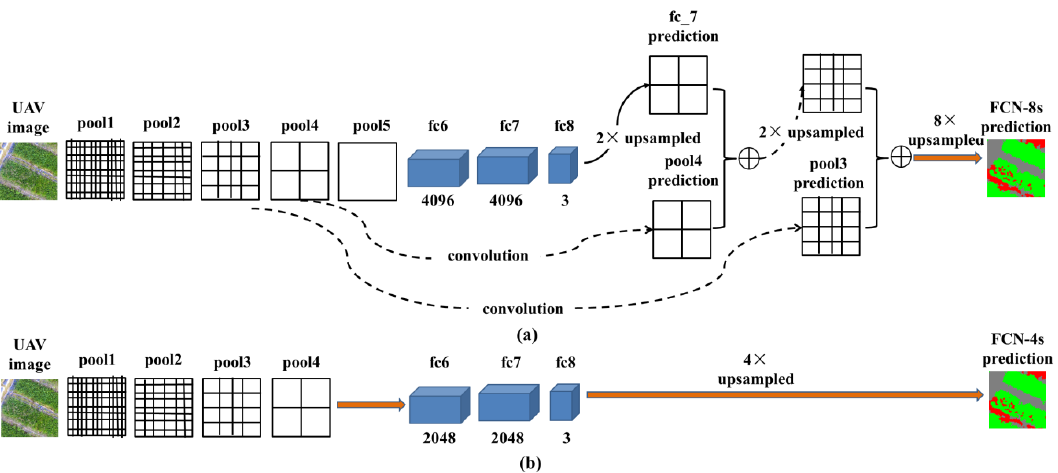
Figure 4. The illustration of the architecture of fully convolutional networks (FCN): ( a ) architecture of classical FCN-8s; ( b ) architecture of the modified FCN-4s.